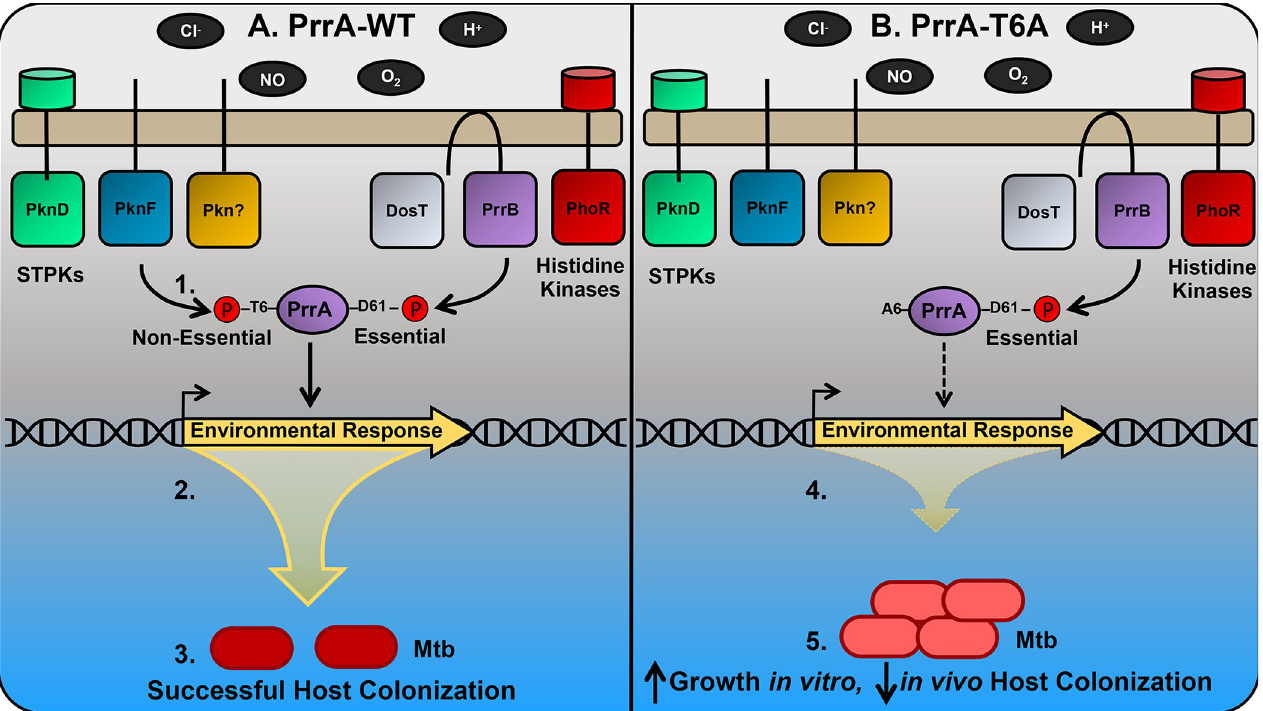
Fig 9. Schematic model of environmental signal integration via PrrA in Mtb. A schematic model illustrating signal integration and outcome in the presence of WT PrrA (A) versus a STPK-phosphoablative PrrA-T6A variant (B) is shown. 1. In addition to the cognate HK PrrB, other HKs are predicted to interact with PrrA [64], while several STPKs are predicted to phosphorylate PrrA [29, 48]. Phosphorylation of PrrA by STPKs is non-essential for Mtb viability in rich broth. In contrast, HK-mediated phosphorylation of PrrA is essential for Mtb viability in rich broth, even though PrrB is non-essential. 2. PrrA contributes to the control of Mtb transcriptional response to acidic pH, Cl - , nitric oxide (NO), and hypoxia (low O 2 ), with PrrA function regulated by both STPK- and HK- mediated phosphorylation. 3. Appropriate environmental response via WT PrrA results in adaptation, proper Mtb growth control, and successful host colonization. 4. When STPK-mediated phosphorylation of PrrA is prevented at the T6 residue (PrrA-T6A variant), appropriate transcriptional response to pH, Cl - , NO, and hypoxia is prevented (predominantly dampened). 5. The disrupted transcriptional response consequently results in failure of Mtb to adapt to its local environment, with the failure to respond to growth-inhibiting cues increasing Mtb growth in vitro and attenuating the bacterium’s ability to colonize the host in vivo .